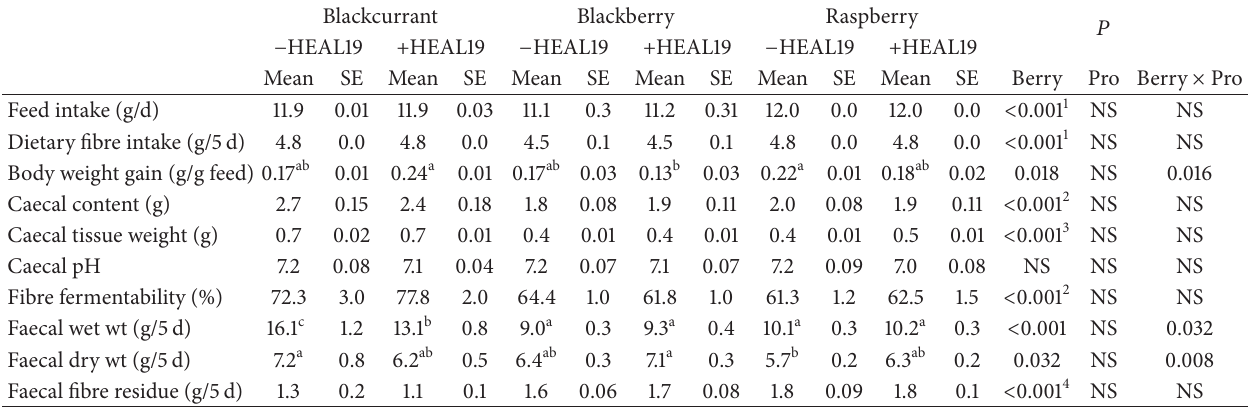
Table 3: Feed and dietary fibre intake, body weight gain, caecal content, caecal tissue weight, caecal pH, dietary fibre fermentability, and faecal wet and dry weight in rats fed diets containing blackcurrant, blackberry, and raspberry, with the same diets supplemented with L. plantarum HEAL19. Blackcurrant Blackberry Raspberry